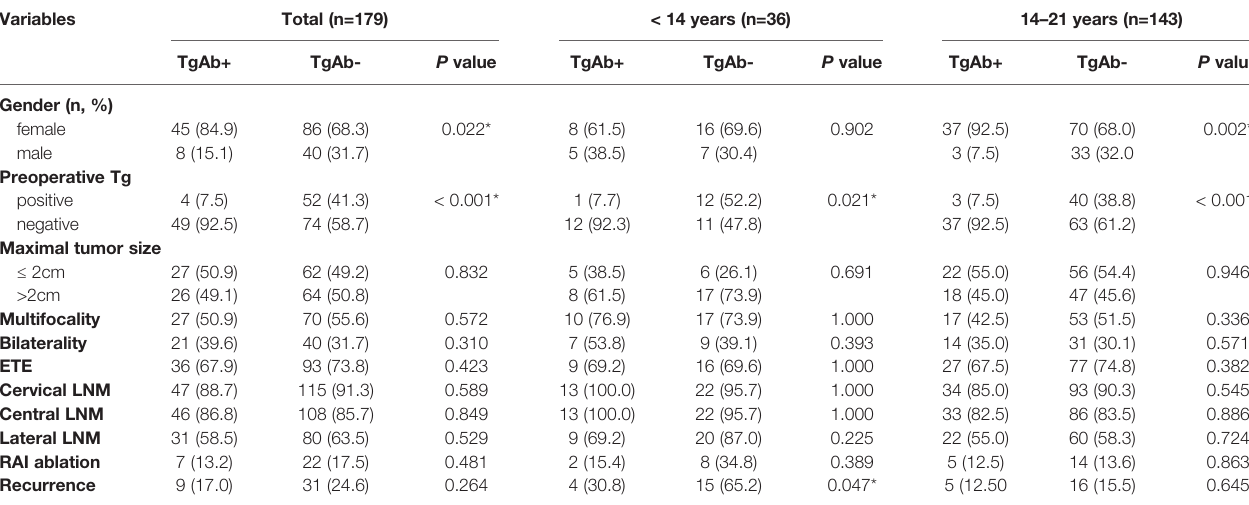
TABLE 2 | Clinicopathologic features of PTC patients with positive and negative TgAb in different age groups.